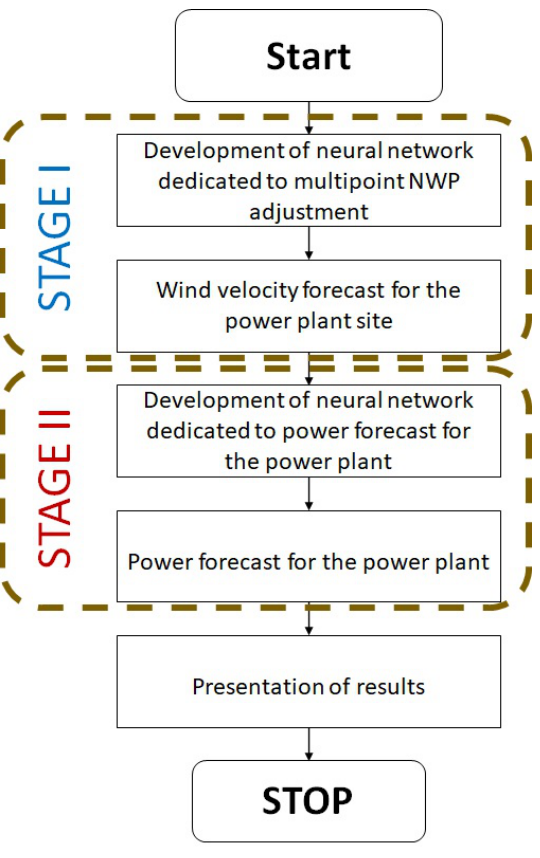
Figure 33. Block diagram of the adjustment and power forecast system for the power